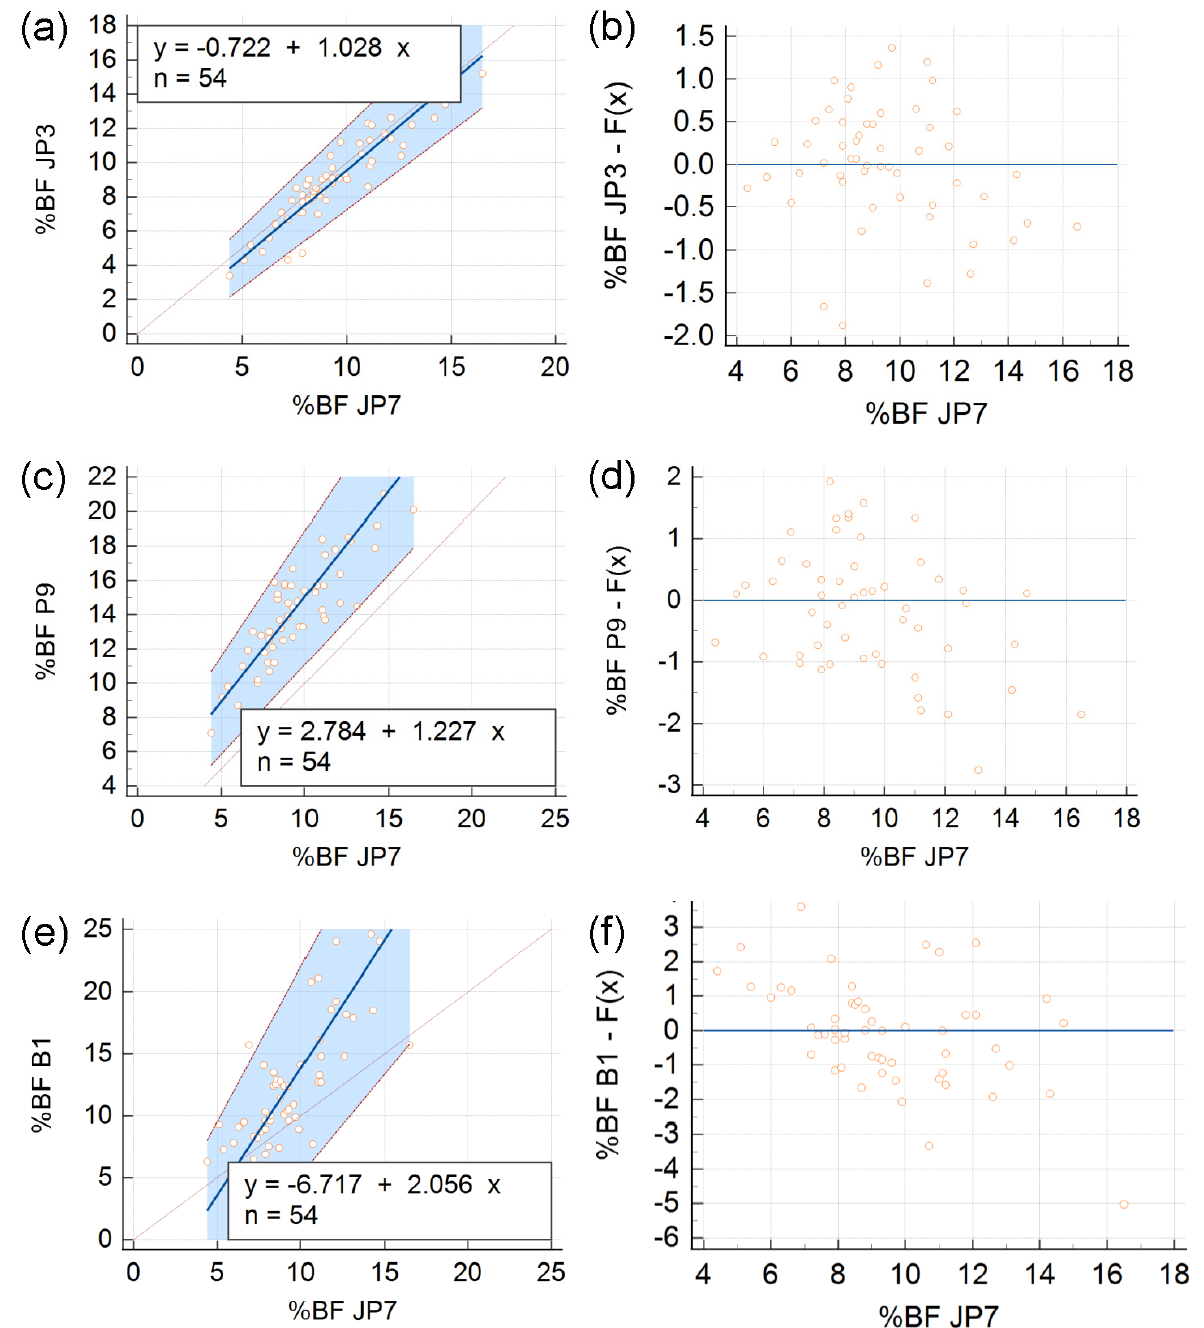
Figure 3. Method comparisons based on Passing–Bablok (PB) regression. Three prediction formulas (JP3, P9, and B1) are compared to the reference (JP7) formula; panels ( a , c , e ) show regression lines (thick solid lines) and give their equations, whereas ( b , d , f ) are plots of the corresponding residuals—differences between individual data points and the values predicted by the regression equation, y = F ( x ). In each of panels ( a , c , e ), the regression line is flanked by dotted lines depicting its confidence interval (shaded in blue); next to them, the identity line, y = x , is represented as a thin solid line.